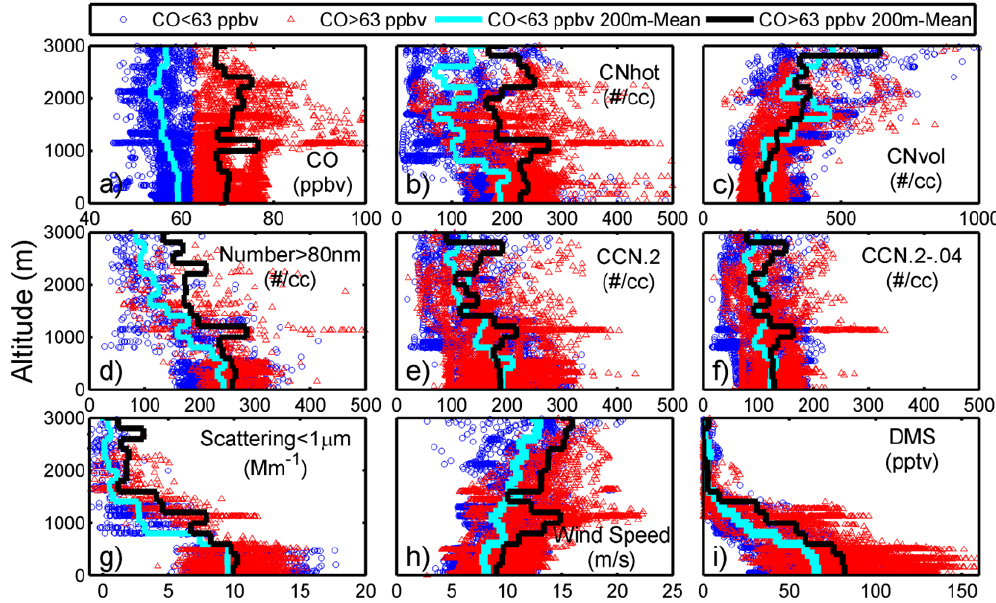
Fig. 9. Vertical profiles for diverse measurements for all PASE data when classified by CO values above (red) and below (blue) 63ppbv as shown in (a) and illustrated in Fig.